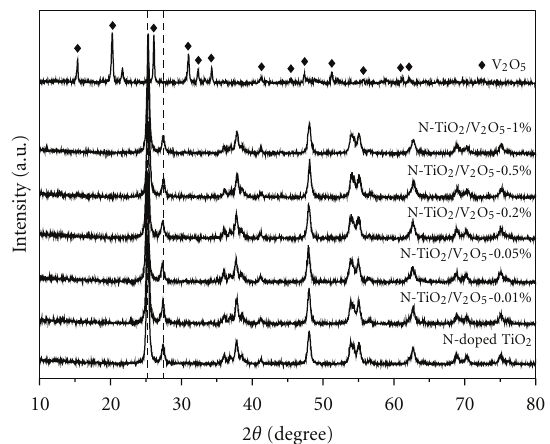
Figure 1: XRD patterns of N-doped TiO 2 , V 2 O 5 cluster modified N-TiO 2 and V 2 O 5